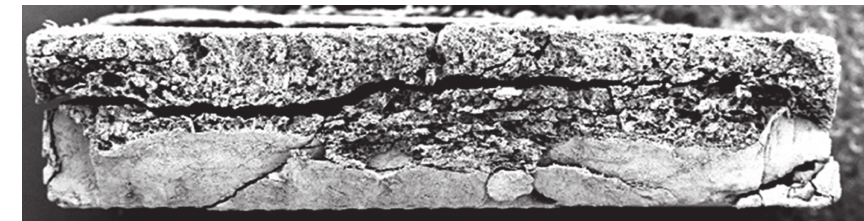
Figure 9. Flexure failed surface at least magnification. The clear demarcation of tension and compression regions can be observed.